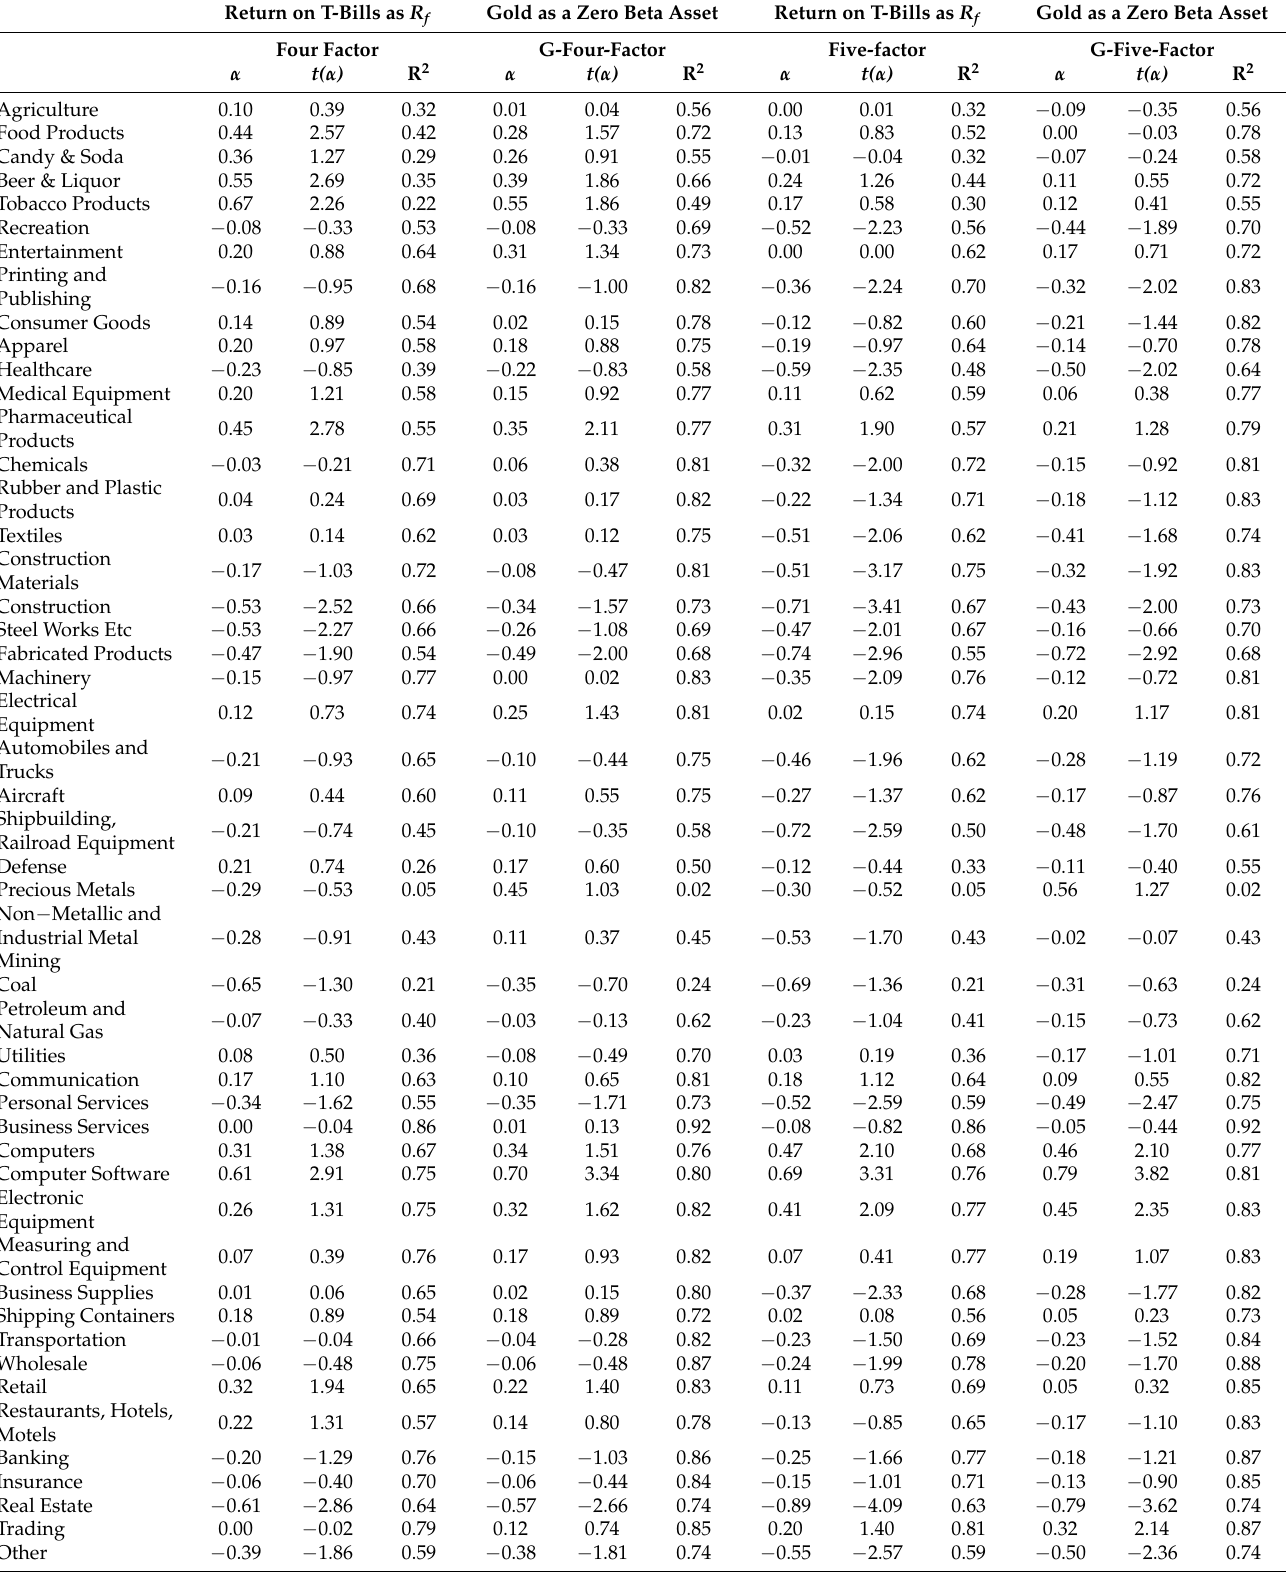
Table 5. Alphas from four-factor, G-four-factor, five-factor, and G-five-factor regressions on 49 indus- try portfolios from January 1981 to December 2015. The table reports alphas ( α ), t-statistics t(a) , and adjusted R-squared of the tested